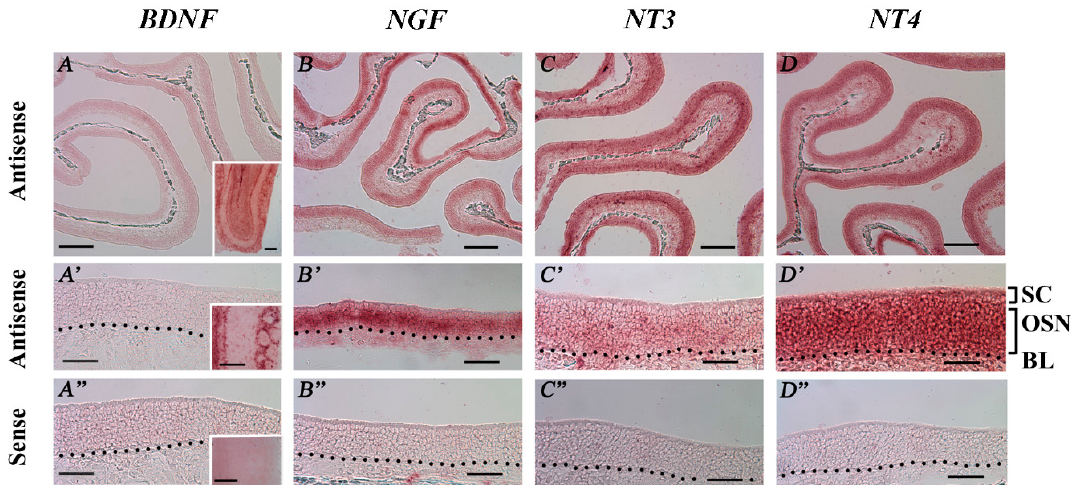
Figure 6. RNA in situ hybridization (RISH) analysis of NT mRNA expression in the MOE of TRPM5-GFP mice. RISH was performed on MOE coronal sections obtained from regularly housed TRPM5-GFP mice with digoxigenin-labeled antisense and sense riboprobes targeting each NT. ( A – D ) and ( A’ – D’ ) Low (10 × ) and high (40 × ) magnification images, respectively, of the MOE hybridized with the antisense probes for BDNF, NGF, NT-3 , and NT-4 . SC: sustentacular/supporting cell layer, OSN: olfactory sensory neuron layer, BL: basal lamina—black dotted line. ( A” – D” ) show high-magnification images of sense-probe labeling for BDNF , NGF , NT-3 , and NT-4 , respectively. The sense probes yielded no detectable specific signals in the MOE. Insets in ( A – A” ): RISH images of BDNF mRNA expression in the OB as positive control for the riboprobes used. Scale bars: ( A – D ) 200 µ